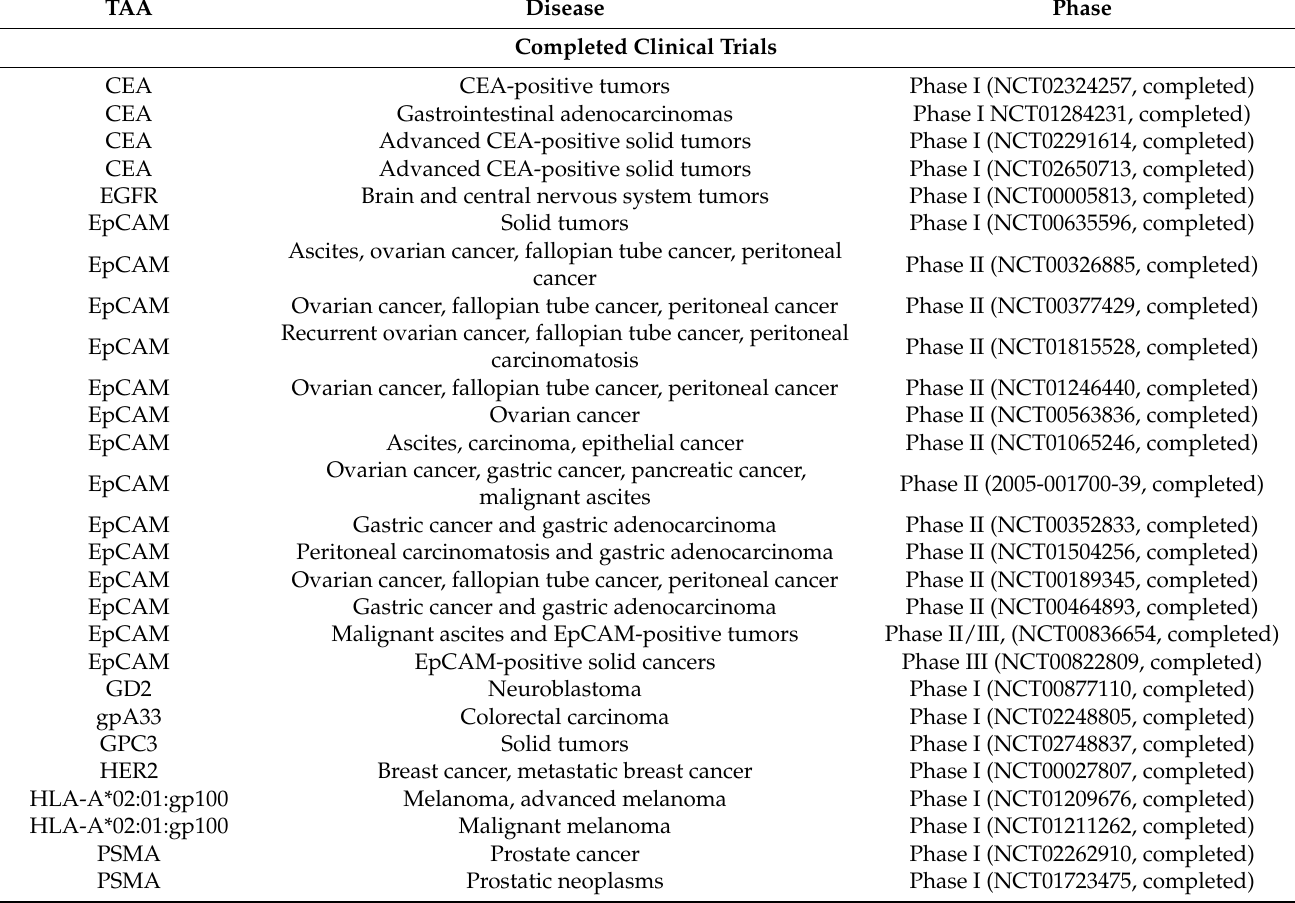
Table 1. Overview of clinical studies involving CD3-BsAbs targeting solid tumors. TAA